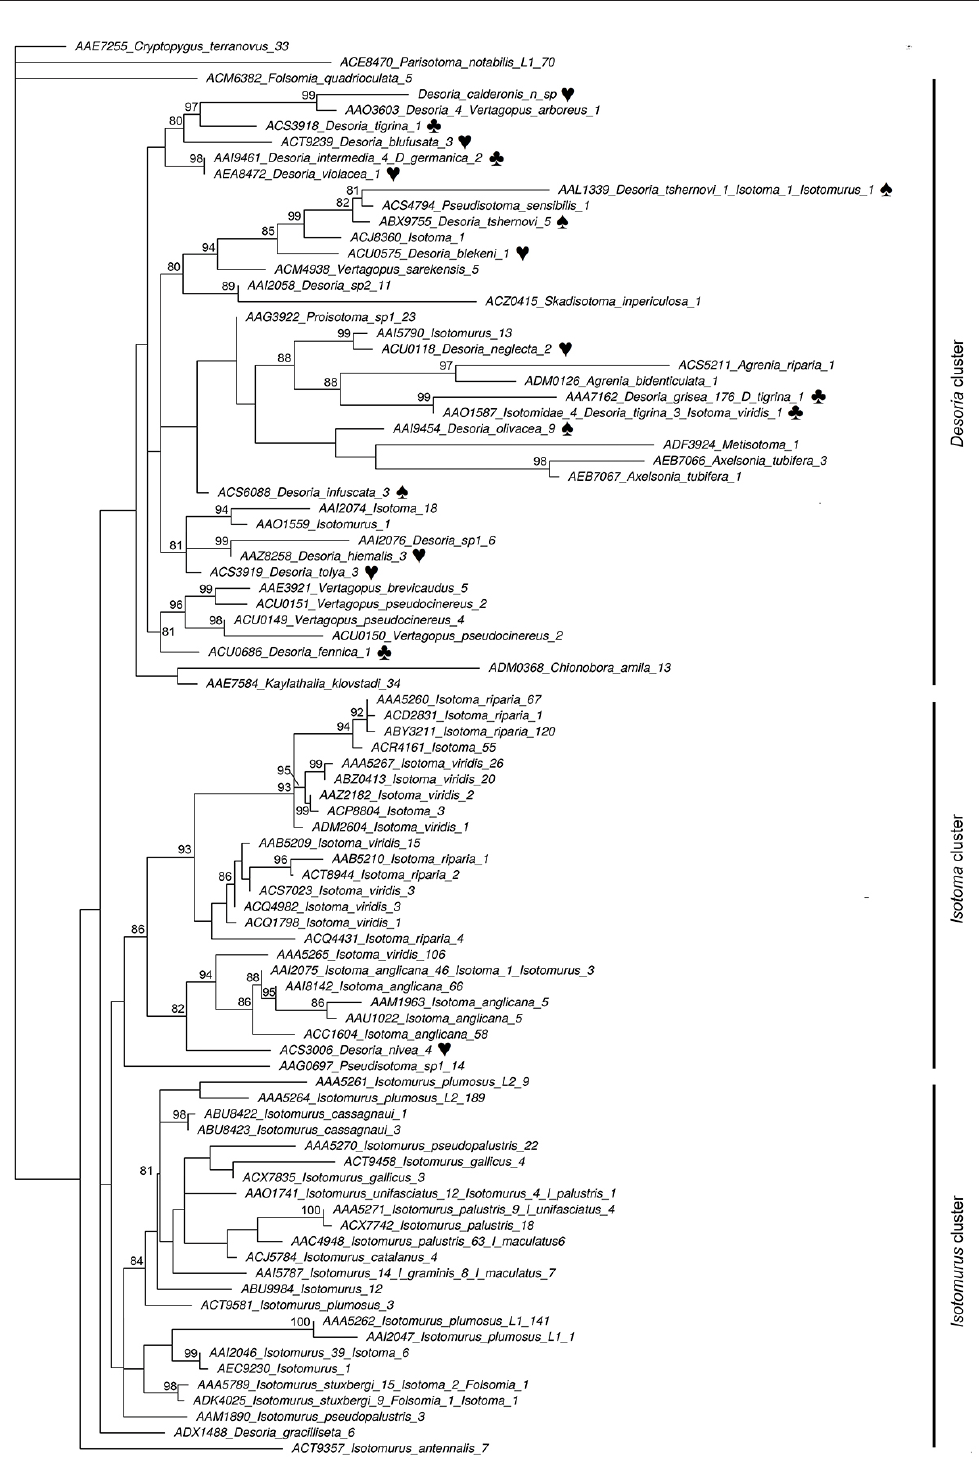
Fig. 6. Phylogenetic tree of Desoria calderonis sp. nov . and related species, on the basis of the cox1 gene. Names include the BOLD bin number, as well as the taxonomic attribution and number of sequences included in the bin. Genera were abbreviated where unambiguous within the bin. When records of the same bin had multiple taxonomic attributions, the one at the lowest level was retained if all were compatible. Alternatively, all were listed separately. Bootstrap support is indicated if > 80. ♠: olivacea - group; ♣: fennica -group; ♥: violacea -group of Desoria